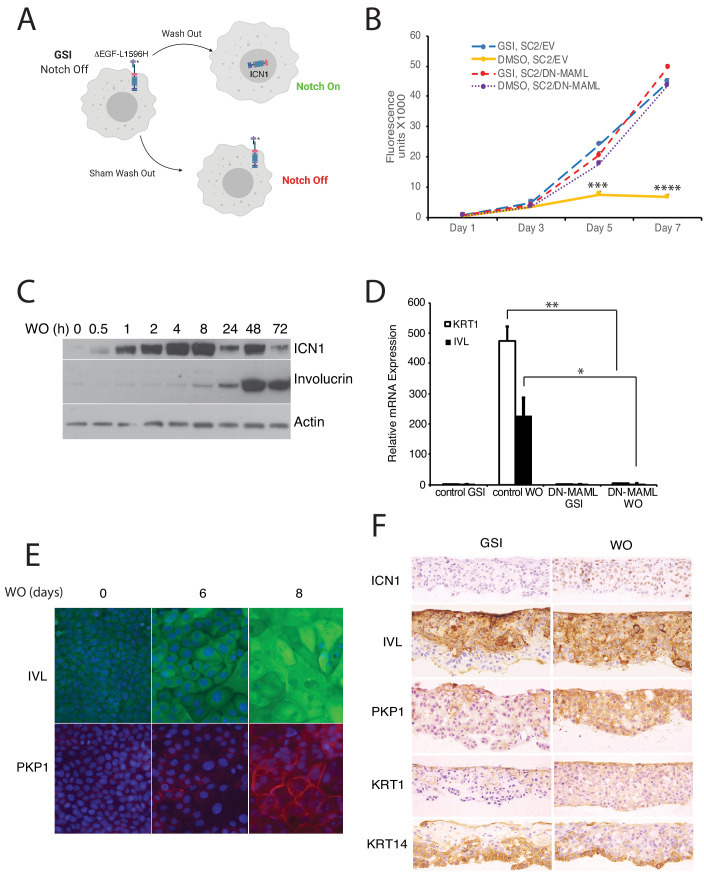
Notch activation induces growth arrest and differentiation of squamous carcinoma cells.(A) Strategy used to activate Notch in a tightly regulated fashion. (B) Notch-induced suppression of SC2 cell growth in standard cultures is abrogated by DN-MAML, a specific inhibitor of canonical Notch signaling. SC2 cells were transduced with empty MigRI virus (EV) or with MigRI virus encoding DN-MAML. Cell numbers at various times post-GSI washout (DMSO vehicle alone) or sham GSI-washout (GSI) were assessed using Cell Titer-Blue on biological replicates performed in quadruplicate. Error bars represent standard deviations. Timepoints with significantly different cell growth between Notch-on cells (DMSO, empty vector) and Notch-off cells (GSI, empty vector; DMSO, DN-MAML1; and GSI, DN-MAML1) are denoted with *** (p<0.005) or **** (p<0.0005) (two-tailed student t test). (C) Western blot showing the kinetics of activated intracellular NOTCH1 (ICN1) generation and increases in involucrin (IVL) following GSI washout in SC2 cells in standard cultures. (D) Notch-induced differentiation of SC2 cells is abrogated by DN-MAML. Transcripts for involucrin (IVL) and keratin1 (KRT1) were measured in the presence of GSI and 3 days after GSI washout in SC2 cells transduced with empty virus or with DN-MAML. Transcript abundance in biological replicates performed in triplicate was measured by RT-PCR and normalized against GAPDH. Error bars represent standard deviations of the mean. **, p<0.005; *, p<0.05; two-tailed student t-test. (E) Indirect immunofluorescence microscopy showing staining for involucrin (IVL, green) and plakophilin-1 (PKP1, red) in SC2 cells at time 0 and 6 and 8 days after GSI washout. Nuclei in each image were counterstained with DAPI. (F) Immunohistochemical staining of SC2 cells grown in skin raft cultures for 14 days in the presence and absence of GSI.